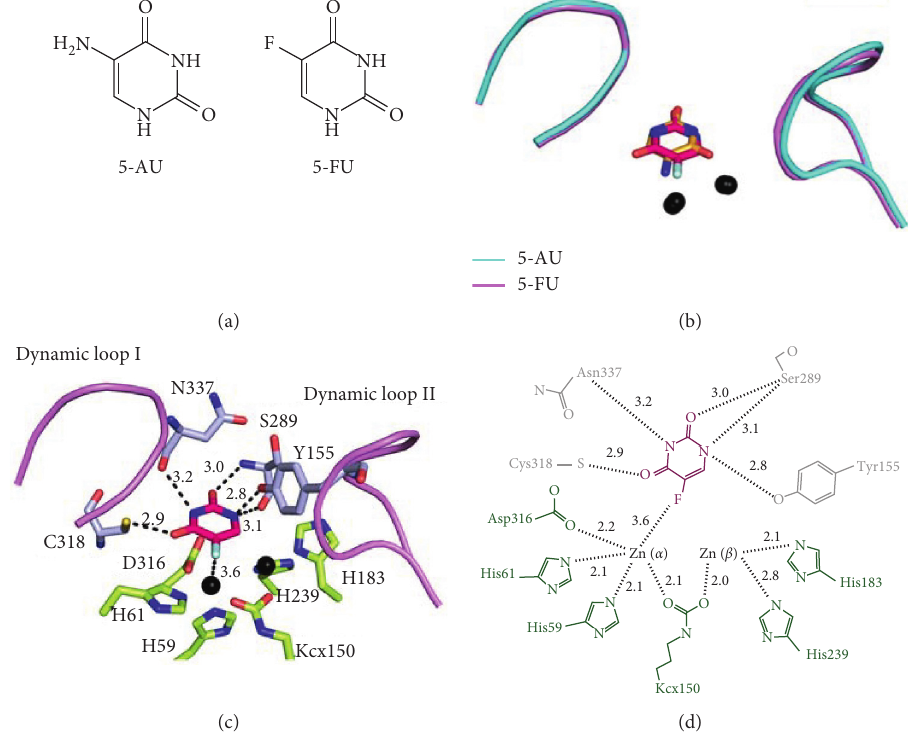
Figure 3: Comparison between the 5-AU and 5-FU binding modes. (a) The structure of 5-AU and 5-FU. (b) The superimposed structures of the 5-AU and 5-FU bound states. The conformation of the dynamic loops in both binding states is similar, but the orientations between 5-AU and 5-FU (hot pink) are different. (c) The interactions of PaDHPase with 5-FU. Zn α and the substrate binding sites (gray) in PaDHPase were involved in 5-FU binding. Dynamic loops are colored in light pink. 5-FU interacted with the main chains of residues Ser289 and Asn337 and the side chains of residues Tyr155 and Cys318. The distances are shown on dotted lines. (d) 5-FU interacted with Zn α , Ser289, Cys318, Asn337, and Tyr155. Residues (His59, His61, Kcx150, His183, His239, and Asp316) required for metal binding are colored in